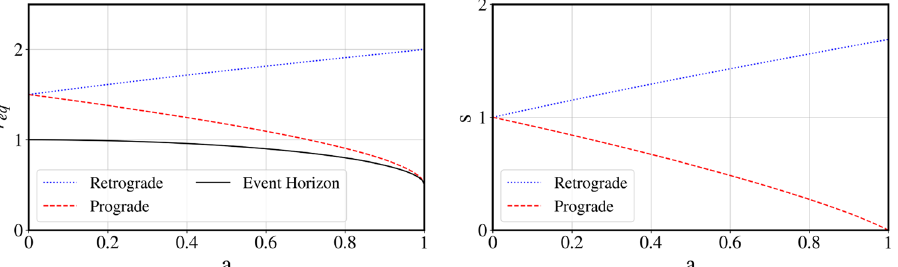
Figure 5. Phase-space portrait for light trajectories obeying Eq. (11) with a retrograde) with the arrows’ coloring indicating the magnitude of change (brighter hues imply longer vectors). The stable and unstable manifolds are drawn which behave approximately linear with a flatter and steeper slope than Fig. 3 for respectively the prograde and retrograde orbits. Note the substitution u critical impact parameter unlike the Schwarzschild case. Therefore the figure remains in r not u like Fig. 3.